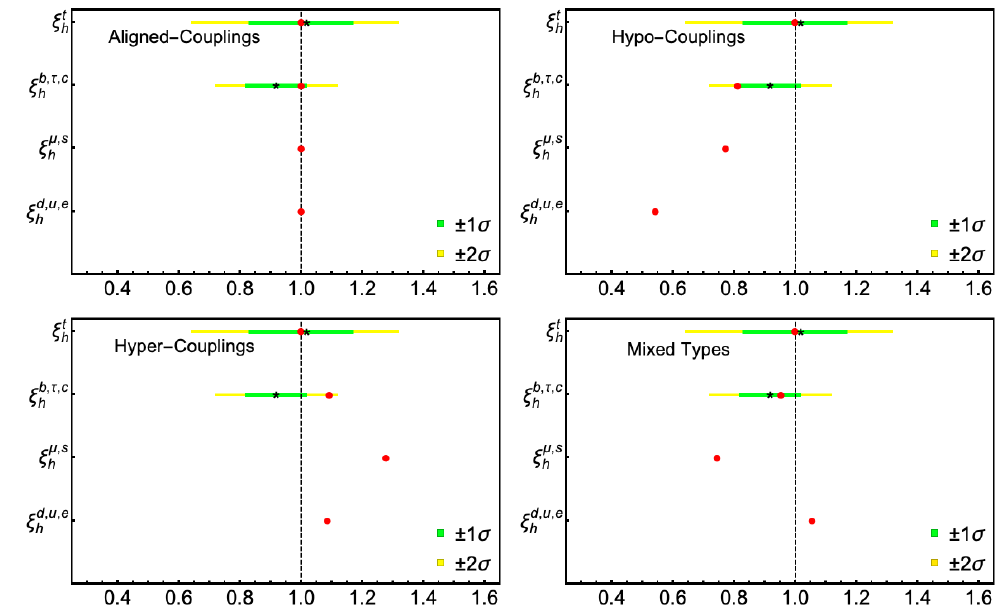
Figure 2 . The red dots are predictions for the modi(cid:12)ed couplings of fermions in the sets f m t g , f m b ; m (cid:28) ; m c g , f m (cid:22) ; m s g , and f m d ; m u ; m e g to the SM-like scalar. The four di(cid:11)erent benchmark scenarios are de(cid:12)ned in table 2. The vertical dashed line corresponds to the SM expectation. The black star is the central value of the measurement with green (yellow) bands being the 1 (cid:27) (2 (cid:27) ) ranges. For simplicity the measured couplings of the Higgs to the bottom quark and tau lepton have been merged here into a single one, (cid:20) b;(cid:28) = 0 : 92 (cid:6) 0 :